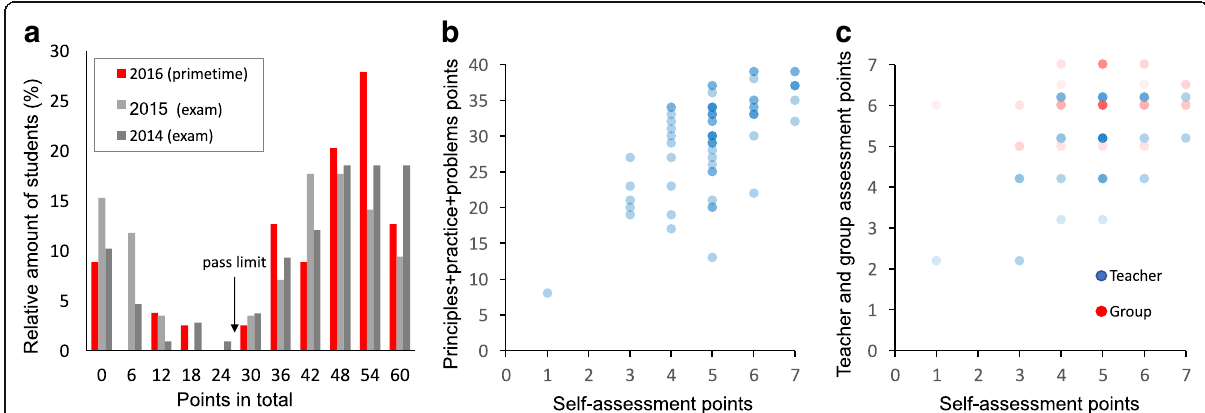
Fig. 5 Analysis of the points in assessment. a The normalized distribution of total points. The pilot course is compared with two courses taught in earlier years using flipped classroom and assessed mainly by a final exam ( N 2014 = 108, and N 2015 = 85, N 2016 = 79, N 2017 = 82). The pass limit is 30 points. b Correlation between points from self-assessment and the sum of points from principles, practice, and problems. c Correlation between self- and teacher assessment and self- and group assessment points. In b and c , color intensity is proportional to the frequency of occurrence. In c , teacher and group assessment symbols are slightly offset for clarity